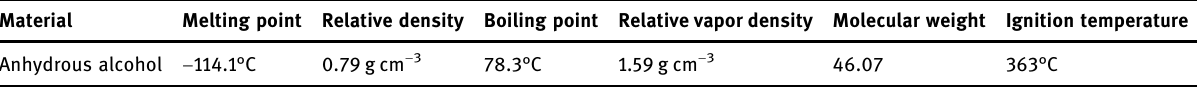
Table 4: Parameters of anhydrous